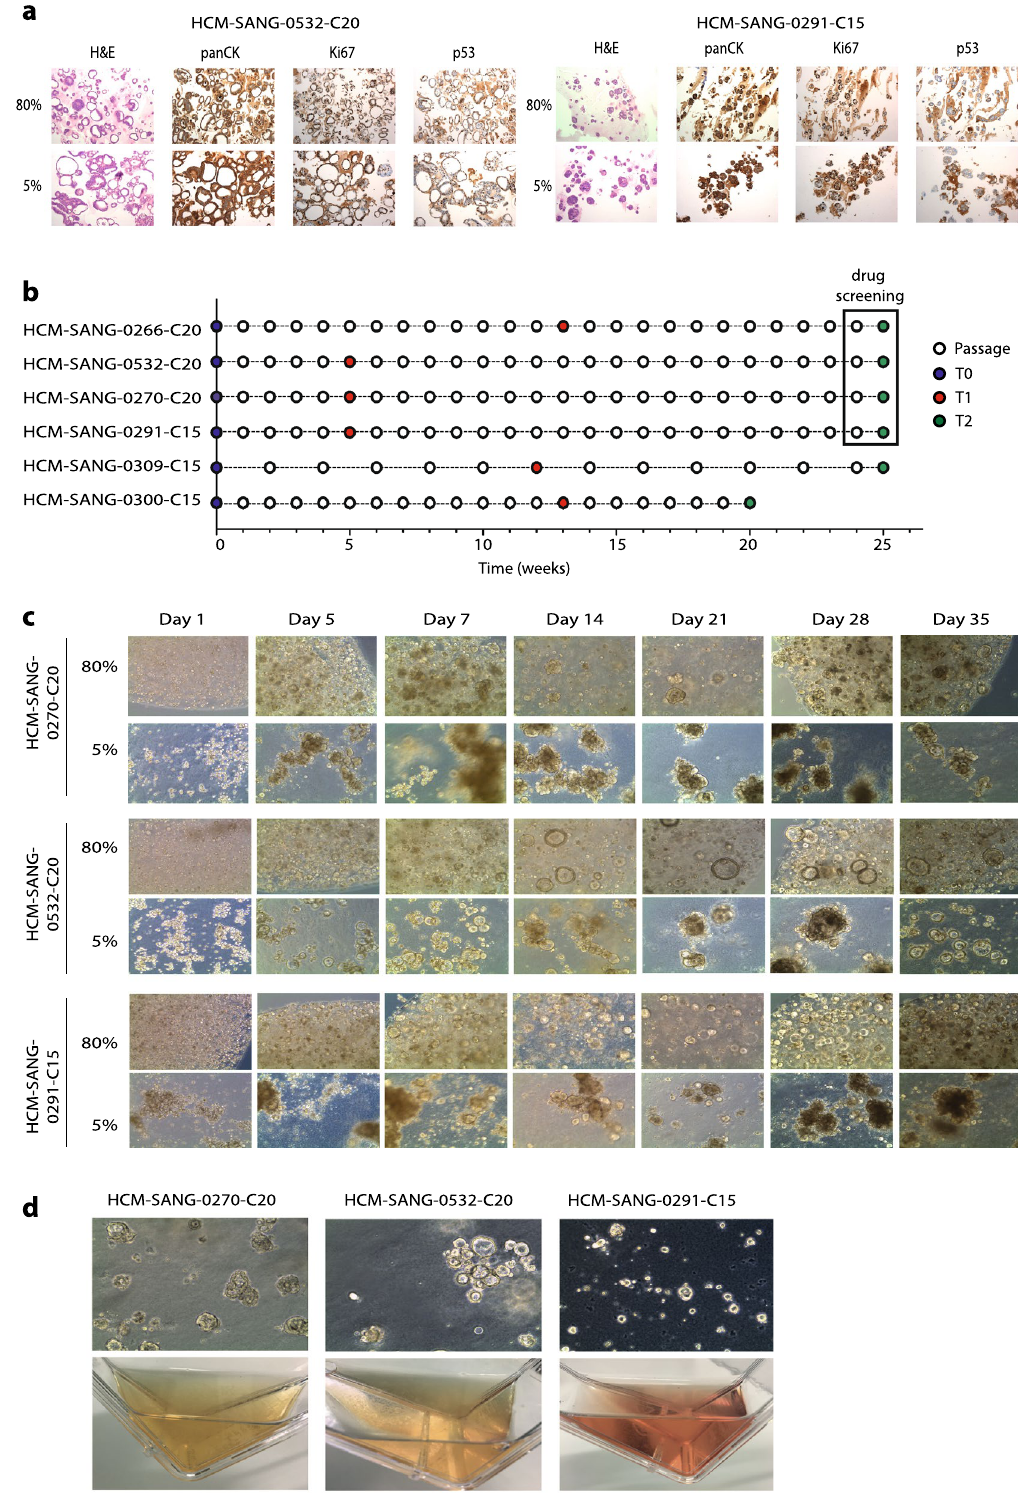
Figure 1. Alternative organoid culturing techniques and longitudinal study to assess 5% ECM culturing feasibility. ( a ) Representative images of H&E staining and IHC of panCK (pan-cytokeratin), Ki67 and P53 in two organoids cultured in either 80% ECM domes or 5% ECM suspension. All images are 10X magnification. ( b ) Study design comparing the 5% ECM with standard conditions. Samples were taken at the start (T0), after approximately 1–3 (T1) and 6 (T2) months, and then used for genomic and phenotypic analyses. ( c ) Representative images of three organoid models over the first 35 days of the study. ( d ) Images of three organoid models growing in T75 flasks in 5% ECM. Organoid images are 10X